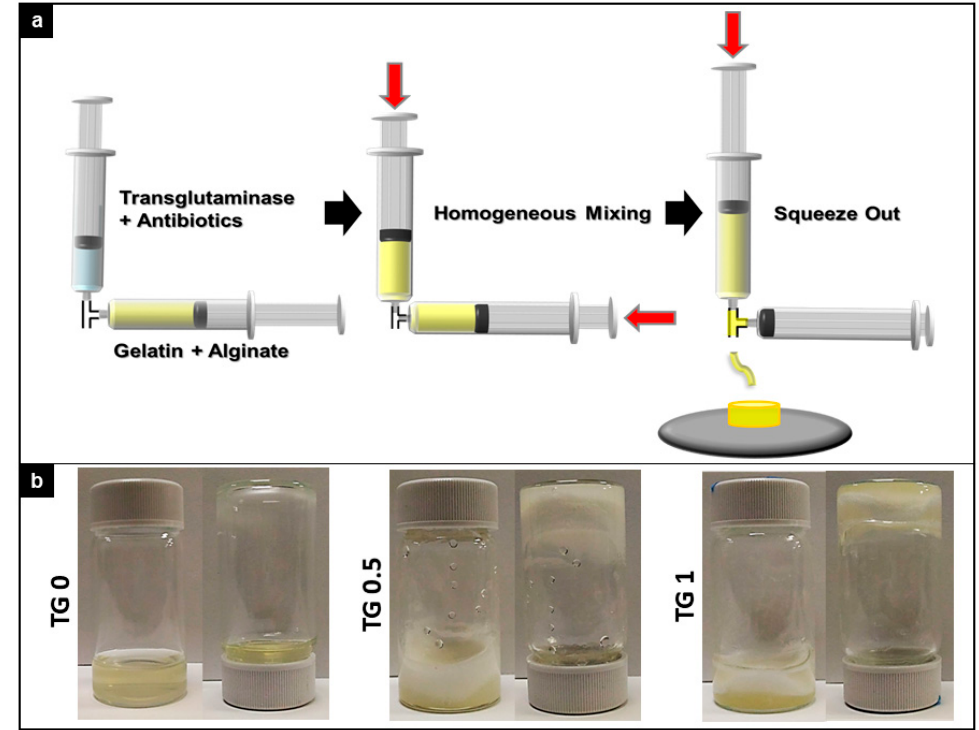
Figure 2. Preparation scheme of crosslink apparatus and degree of crosslink between three differ- ent concentration of transglutaminase (TGase) added. ( a ). Graphical representation of crosslink apparatus for the experiment. ( b ). Visual indication of degree of crosslink between three different concentration of transglutaminase (TGase) added. Both 0.5% and 1.0% TGase can effectively cross link the gelatin/alginate/vancomycin